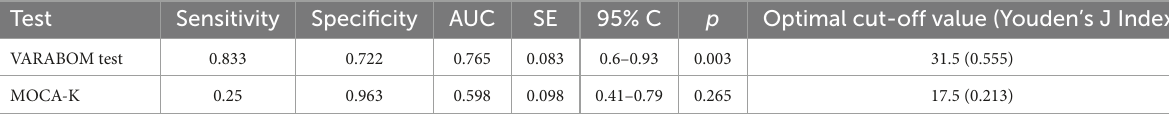
TABLE 4 Statistical comparison between the ROC curves of VARABOM test and MOCA-K